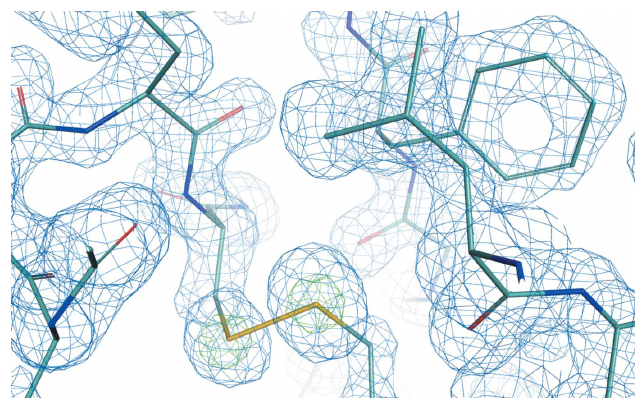
Figure 6 Experimental electron density (blue) from native sulfur anomalous phasing of cubic insulin on data collected at E = 14.2 keV/0.873 A˚ . Density is contoured at 1.5 (cid:2) above the mean electron density value. Model-phased anomalous difference density is shown in green, contoured at 10 (cid:2) above the mean electron density value. This figure was generated in PyMOL